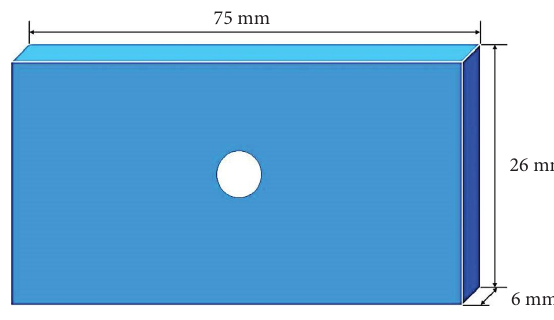
Figure 2: Dimensions of slurry erosion test